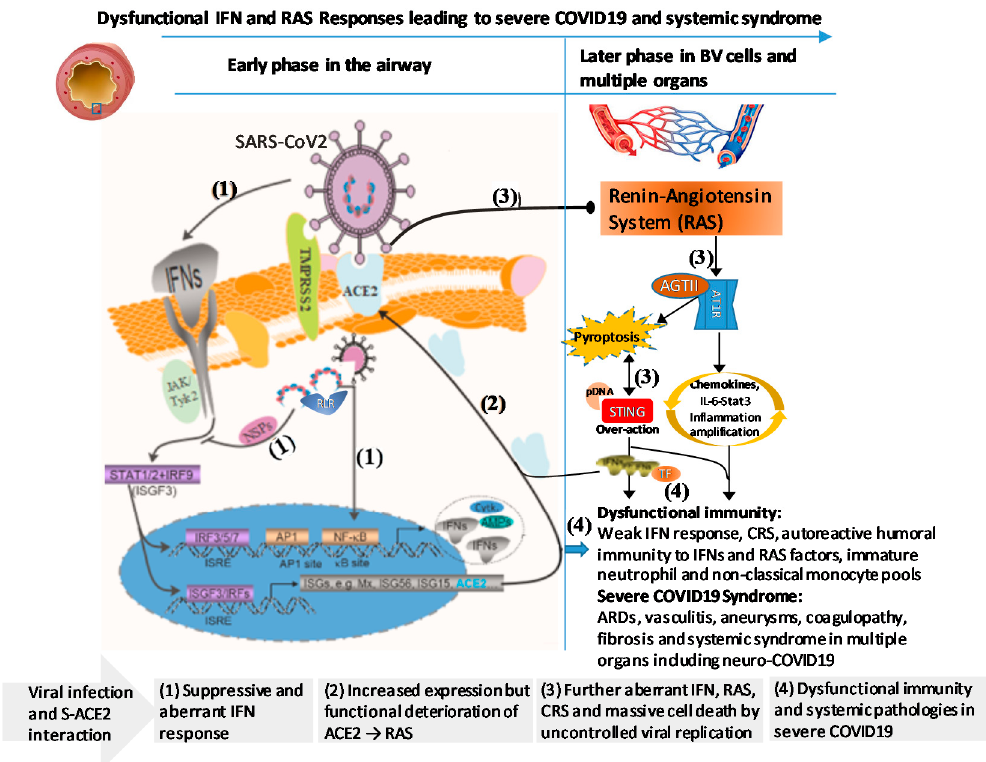
Figure 2. Dysfunctional interferon (IFN) and renin-angiotensin system (RAS) responses leading to severe COVID19. SARS-CoV2, the virus of COVID19, evolves in optimizing its infectivity and contagiousness to induce a weak antiviral innate immune IFN response during its acute phase of infection especially in the susceptible patients due to seniority, gender and existing medical conditions. SARS-CoV2 adopts angiotensin-converting enzyme 2 (ACE2), a critical and multirole component of the body RAS, as a major viral receptor expressed in multiple cell types. The progressive infection of the virus from pneumocytes to BV cells exaggerates RAS imbalance provoking proinflmmation, CRS and massive cell death (pyroptosis) catastrophized with viral spreading, which further provokes coagulopathy / fibrosis (as in Kawasaki syndrome) and autoimmune reactions against IFNs and RAS components. All these collectively lead to a complicated syndrome including systemic virus infection in multiple organs and functional deterioration of RAS plus compounding immunopathies and neurological manifestation. Abbreviations: AGTII, angiotensin II; AP1, activator protein 1 transcription factor; ARD, acute respiratory disease; AT1R, AGTII receptor type 1; BV, blood vessel; CRS, cytokine release syndrome; ISRE, IFN signaling responsive element; ISGF3, IFN-stimulated gene factor 3; NSP, non-structural proteins; RLR, retinoic acid-inducible gene-I-like receptors; pDNA, pathogenic DNA; STING, stimulator of interferon genes; TF, tissue